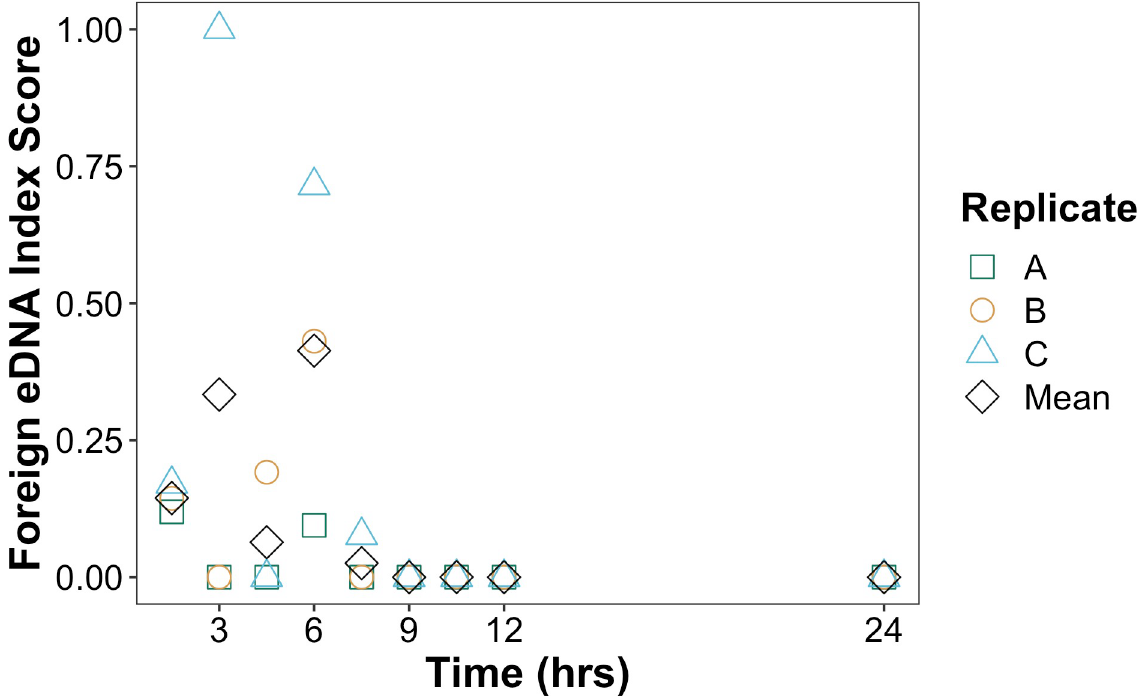
Fig 2. Detection of foreign eDNA over time. Plot of eDNA index for C . idella detected over time per replicate for the first 24 hours at dock replicates A (green squares), B (orange circles), C (blue triangles), and the mean eDNA index across the transect (black diamonds).